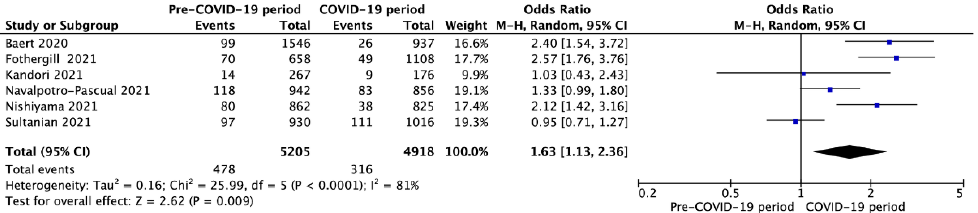
Figure 8. Forest plot of 30-day survival rate in pre- vs. intra-COVID-19 periods. The center of each square represents the weighted odds ratios for individual trials, and the corresponding horizontal line stands for a 95% confidence interval. The diamonds represent pooled results. Legend: CI = confidence interval; OR = odds ratio. Table 2. Survival outcomes among SARS-CoV-2-positive vs. -negative patients.